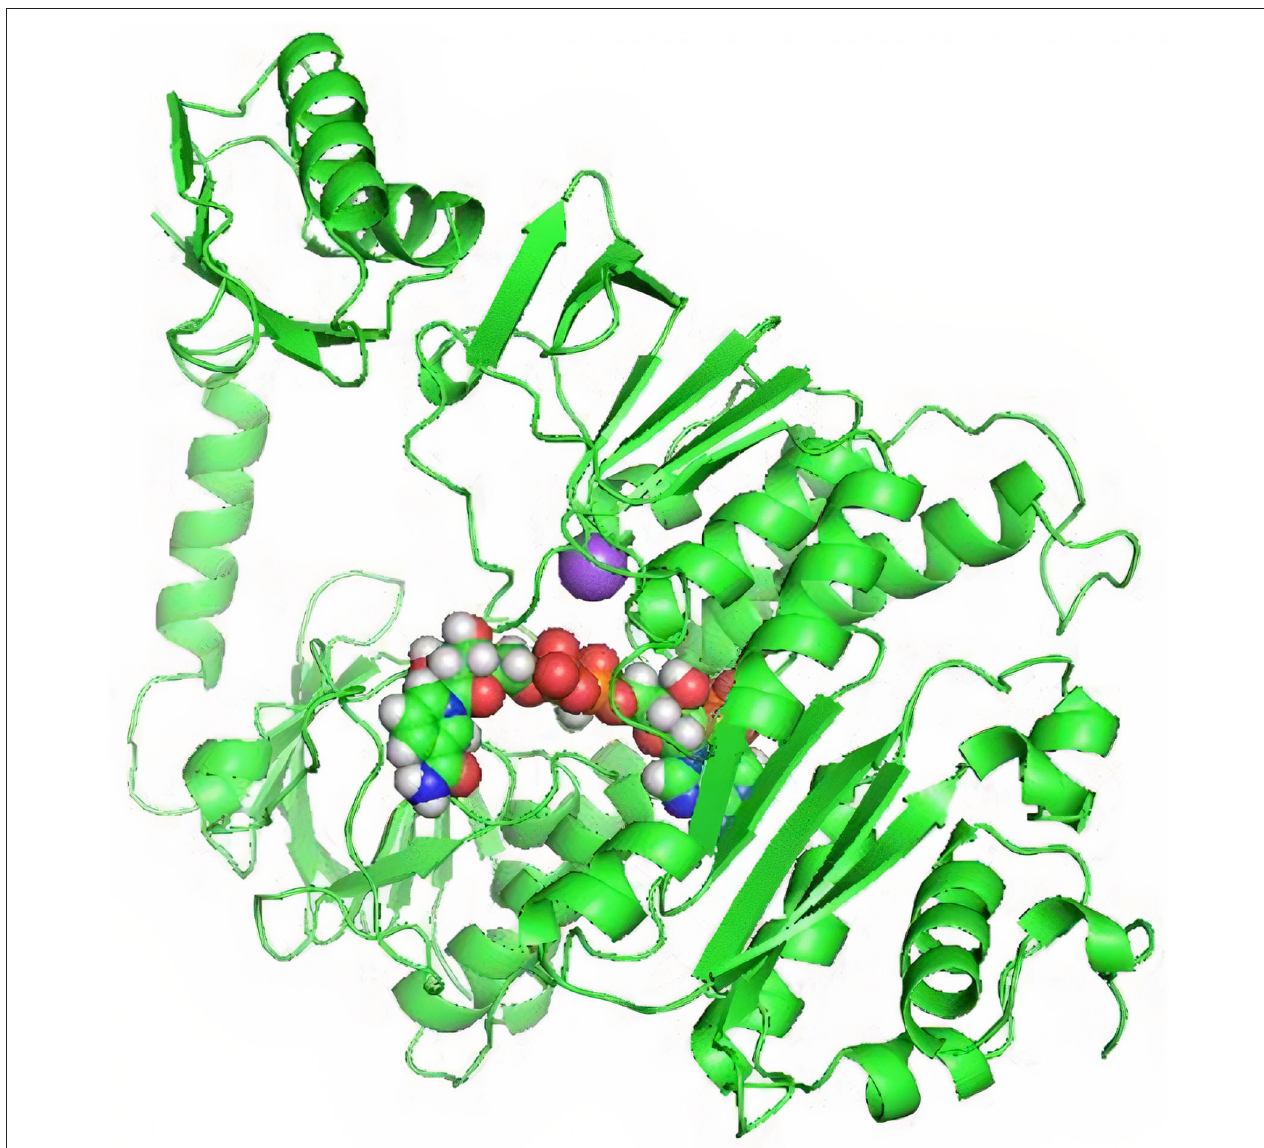
FIGURE 4 | NADP + docking with NADP-binding domain of MerA